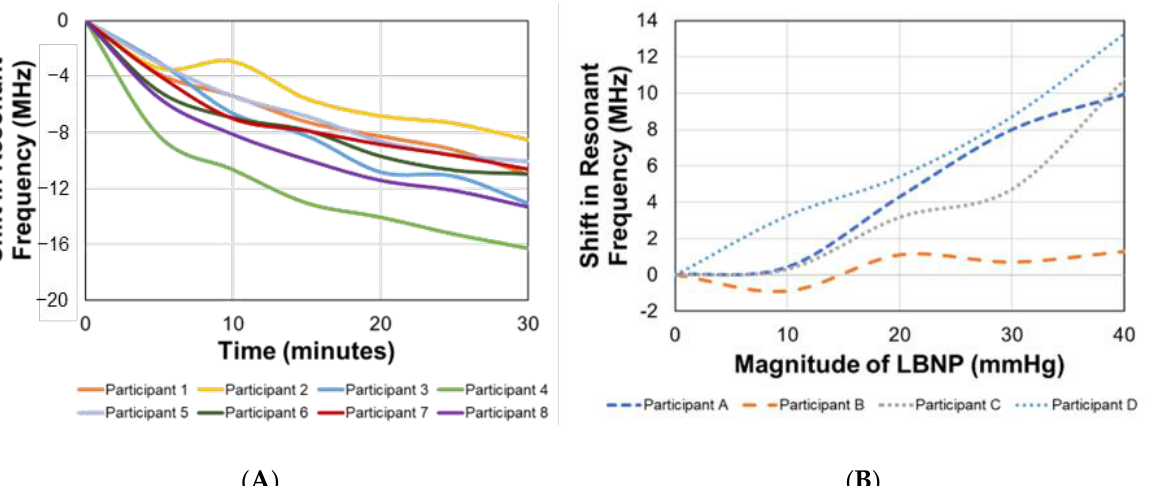
Figure 3. Shifts in EM skin patch sensor’s resonant frequency corresponding with induced bio-fluid shifts over time during C) head down tilt and D) at different pressures during lower body negative pressure protocol.